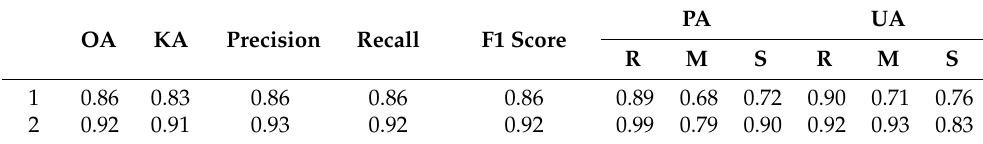
Table 5. Accuracy assessment of crops classification for IO-Growth method and the method that did not combine growth stages. Note that numbers of methods and the abbreviations are explained. PA UA OA KA Precision Recall F1 Score R M S R M